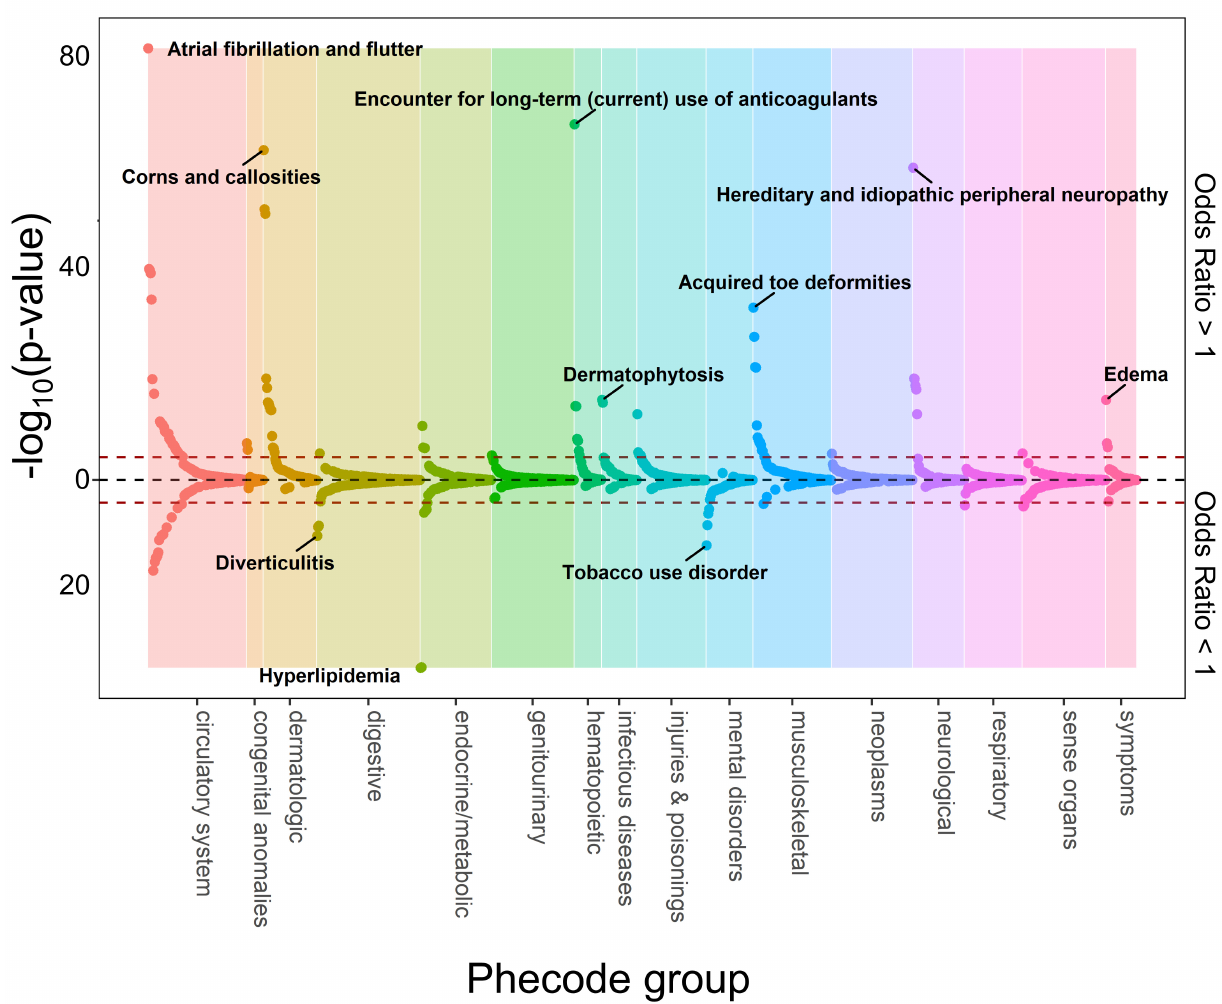
Fig 2. Phenome-wide associations with genetically predicted height in non-Hispanic White individuals. Plot of phecodes versus -log 10 (p-value) for association with genetically-predicted height in non-Hispanic White participants in MVP. Phecodes were limited to single decimal place for clarity (e.g., 427.2 for atrial fibrillation or flutter is shown but 427.21 for atrial fibrillation is not). Associations with a negative beta coefficient (i.e., odds ratio < 1) are plotted below the x-axis, and those with a positive beta coefficient (i.e., odds ratio > 1) are plotted above the x-axis. Red dotted lines indicate race/ ethnicity-specific phenome-wide significance thresholds ( p < 3.6E-5 for non-Hispanic White). The top association (lowest p-value) within each phecode group is labeled.